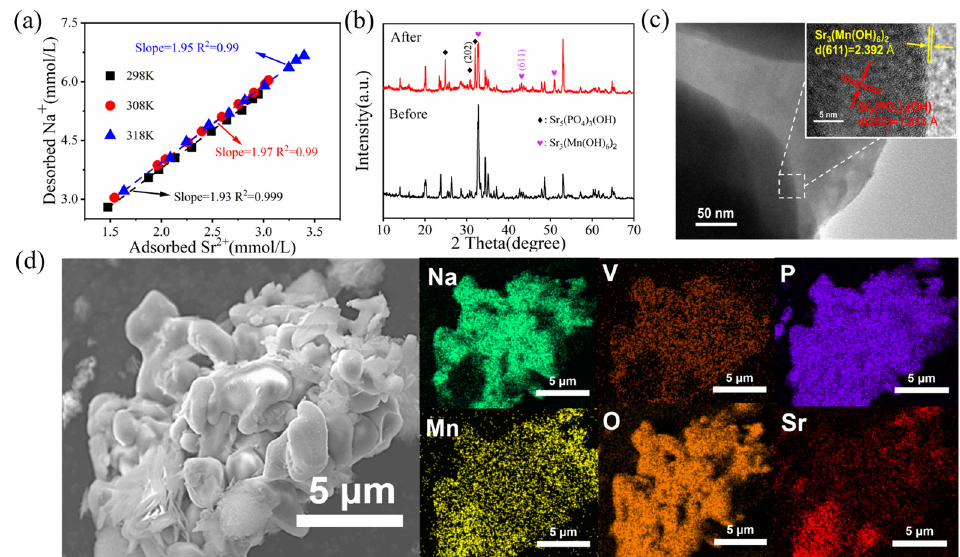
Figure 6. ( a ) Amount of Sr 2+ adsorbed and Na + released in quantitative experiments (m/v = 1, pH = 3, t = 30 min). ( b ) XRD patterns of adsorbent before and after adsorption; ( c ) TEM images of 1V: 9Mn and the enlarged images of the white regions, as indicated in the panels; ( d ) SEM image and the corresponding elemental (Na, V, P, O, Mn, and Sr) mapping images of the NVP@NMP (1V: 9Mn).